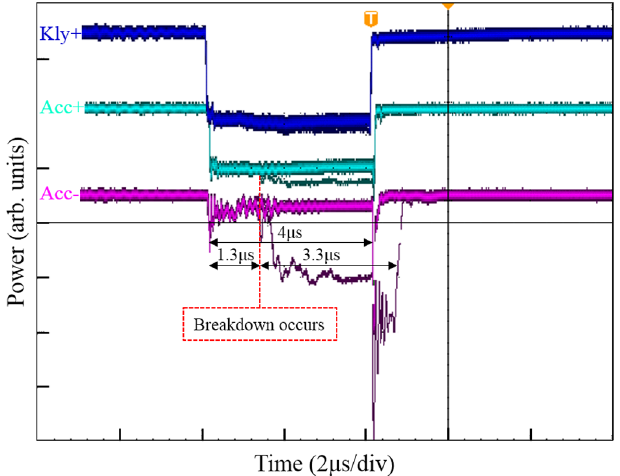
FIG. 7. rf wave distortion for one rf breakdown event during high-power conditioning. Kly þ : forward power from the klys- tron; Acc þ : forward power of the linac; Acc − : reflected power from the